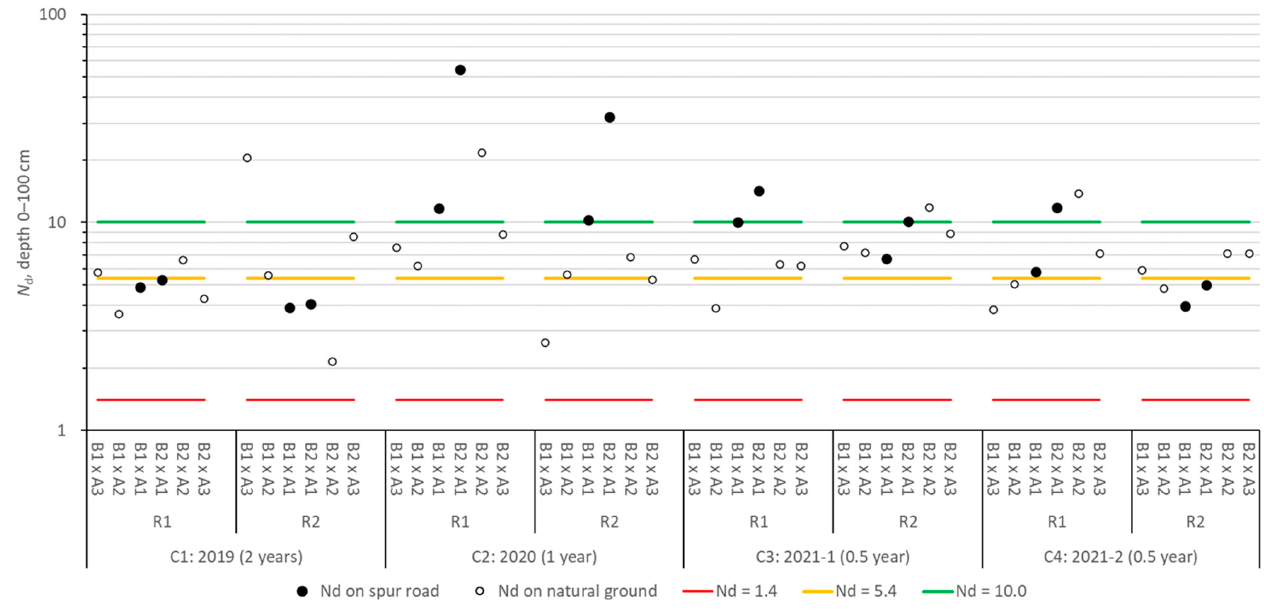
Figure 14. N d —values of Site 2 accompanied with thresholds.